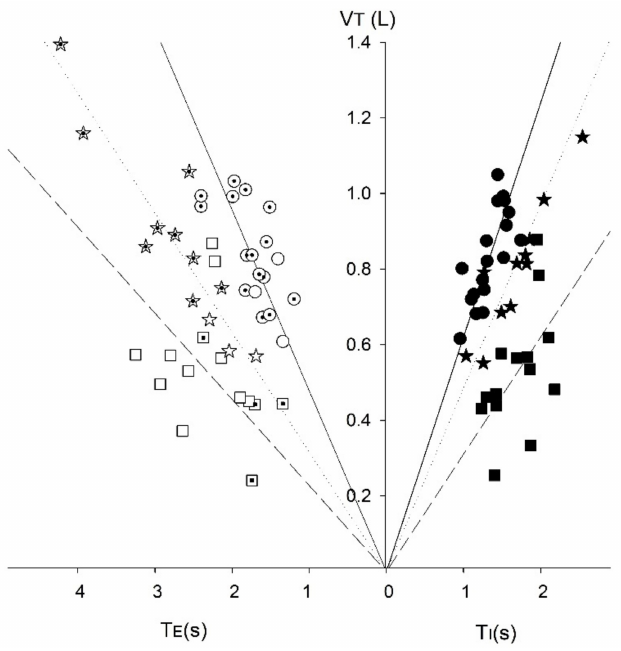
Figure 5. VT-T I -T E diagram for each cluster group: Cluster 1 ( ), Cluster 2 ( (cid:4) ), Cluster 3 ( (cid:79) ), Cluster 4 not shown. The filled T E symbols denote IPF participants. Fitted linear regression lines shown.